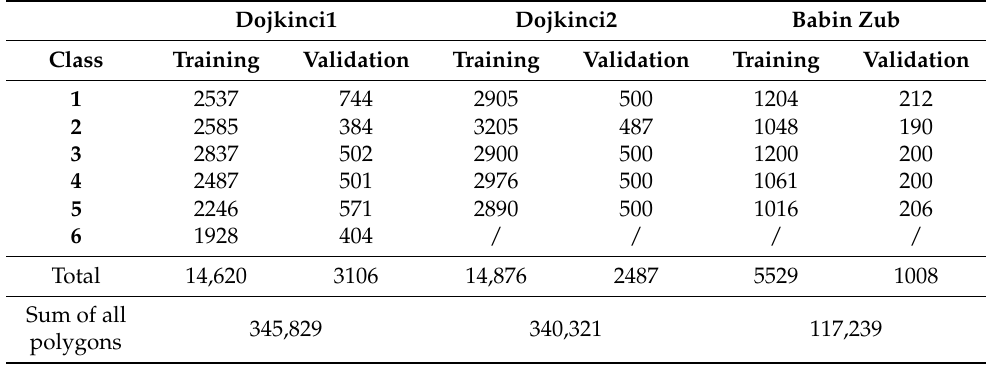
Table 3. The number of marked polygons for training and validation sets in study